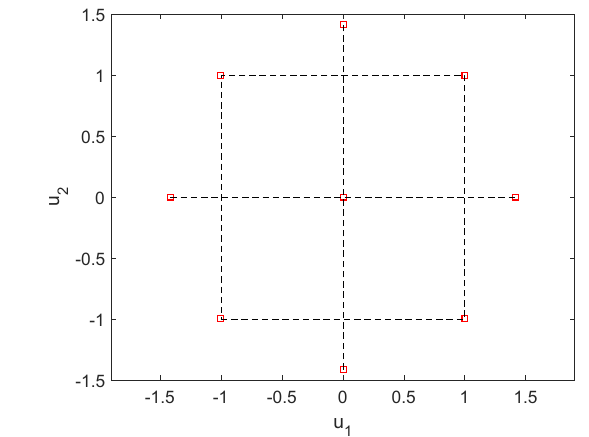
Figure 3. Example of a rotatable central composite design (CCD) in a 2-dimensional standard normal space [ u 1 ,u 2 ] . The CCD con- sists of a central point, a 2 k “factorial design” with 2 levels and k = 2 dimensions, and axial points at distance u = that all the outer points lie on a